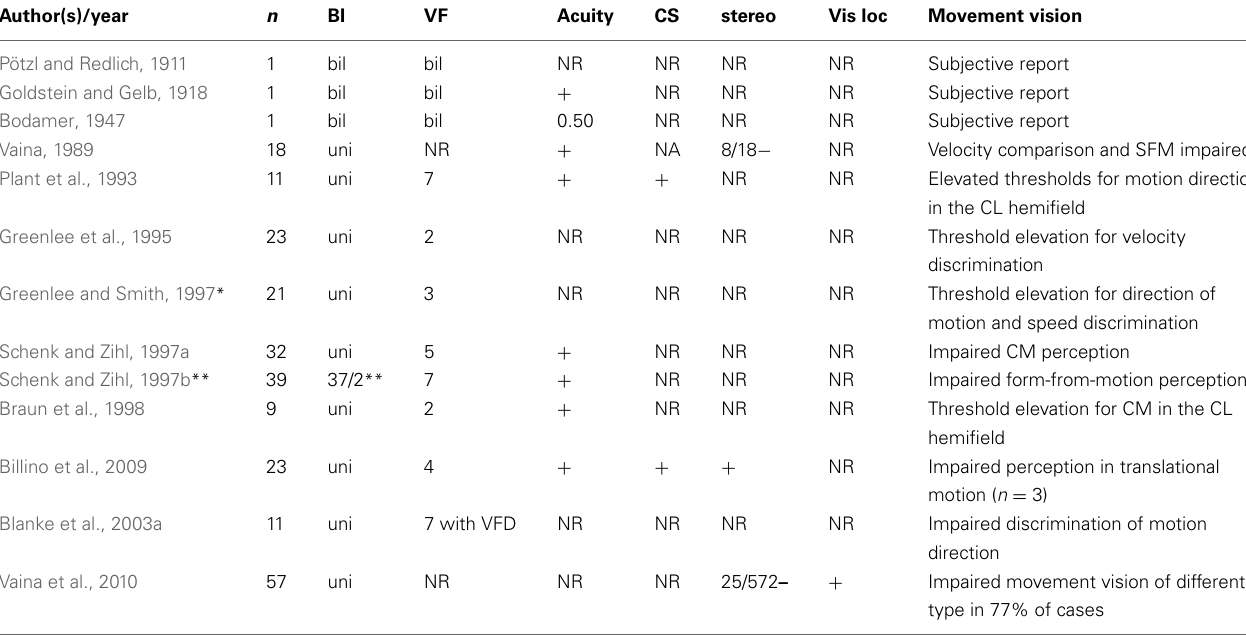
Table 2 | Synopsis of cases reported with motion blindness or impaired movement vision (1911–2014).